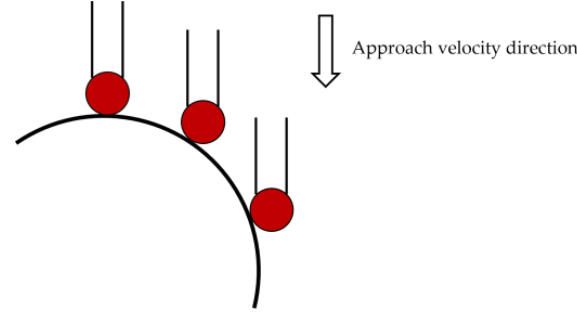
Figure 12. Schematic diagram of altering the measurement angle. The coordinate of the selected measurement points on the calibration ball and the corresponding contact angles are provided in Table